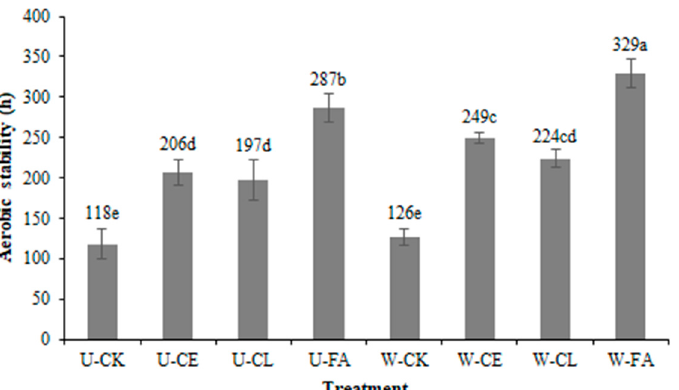
Figure 1. Effect of additives on the aerobic stability (h) of paper mulberry silage after 60 days of ensiling (SEM = 14.47, p < 0.001). Vertical bars are the standard errors of the means, bars with different letters differ ( p < 0.05). a–e: Values shown in different letters in the same column are statistically important ( p < 0.05). Treatment: U, wilt 0 h; W, wilt 3.5 h; CK, control (no additives); CL, Enterococcus durans ; CE, cellulase; and FA, formic acid.